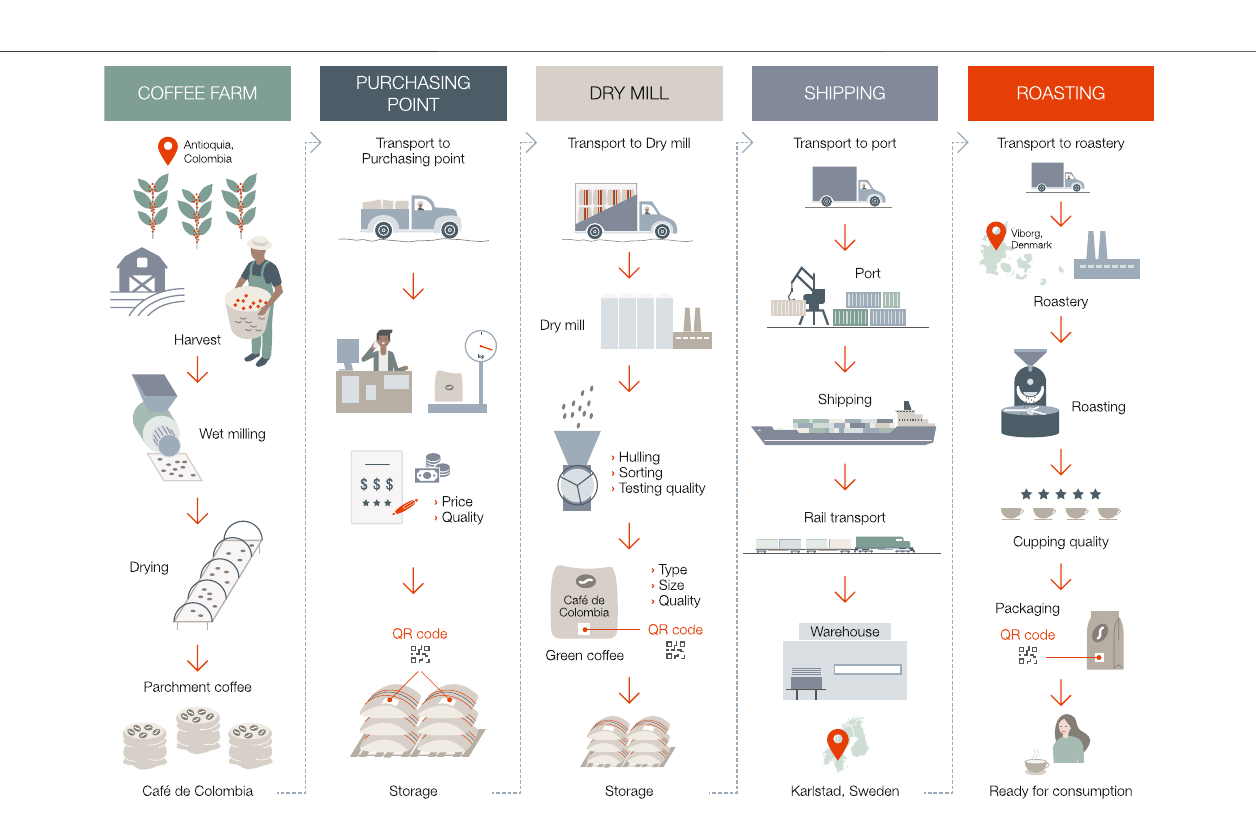
FIGURE 2 | Full supply chain with all stakeholders and their corresponding processing procedures (Bager et al., 2022).